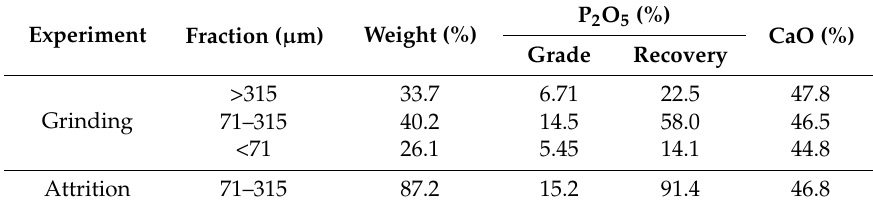
Table 9. Grade and recovery of P 2 O 5 after optimum grinding and attrition